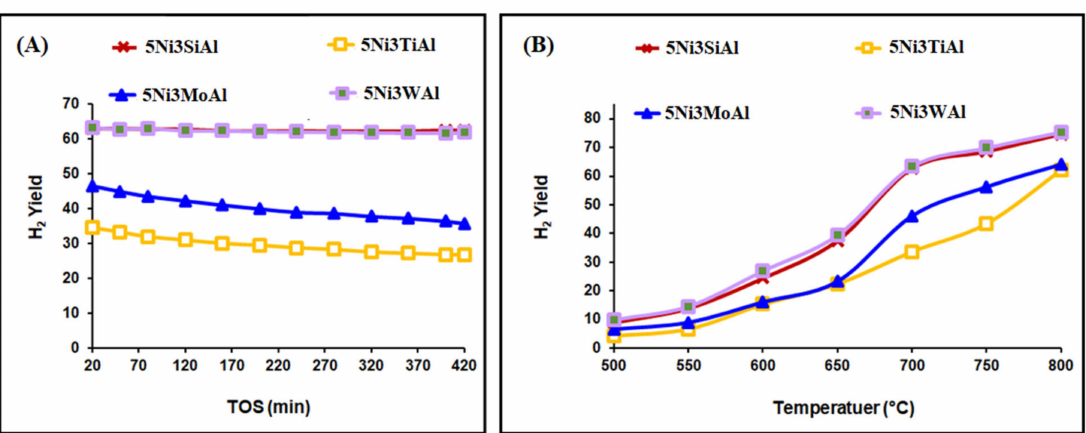
Figure 2. ( A ) H 2 yield over different catalyst systems up to 420 min TOS at 700 ◦ C; ( B ) H 2 yield over different catalyst systems in the 500–800 ◦ C reaction temperature